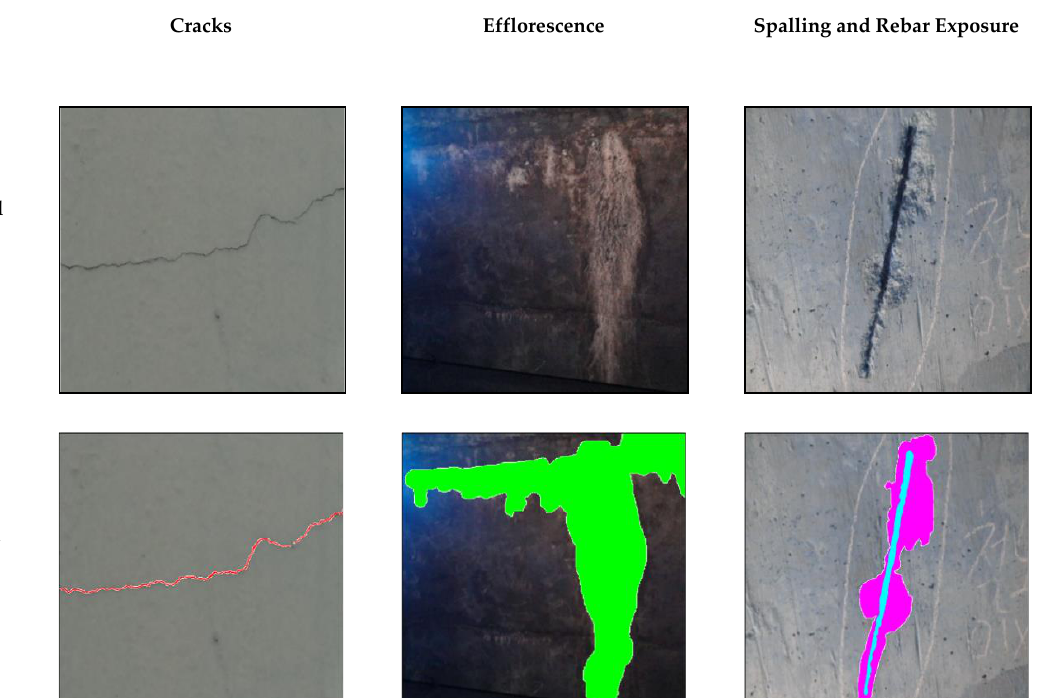
Figure 8. Examples from concrete dataset with damage and respective ground truths (in colors).